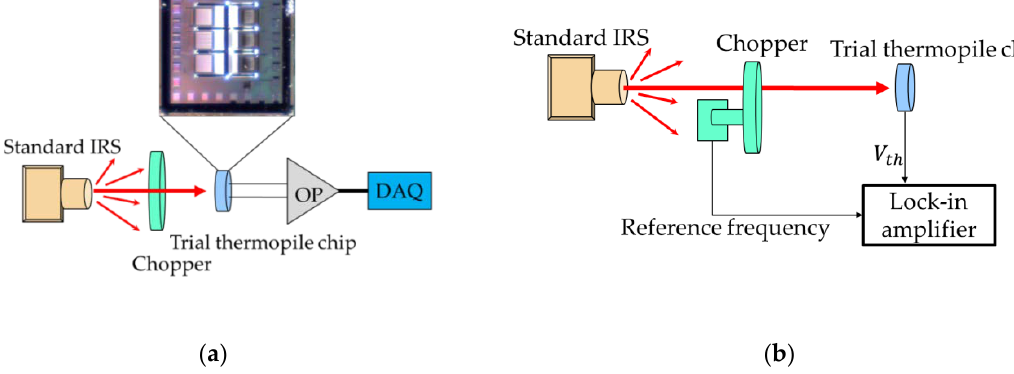
Figure 10. Setups of the experimental measurement framework of the output voltage ( a ) and the frequency response ( b ) for the trial thermopiles.